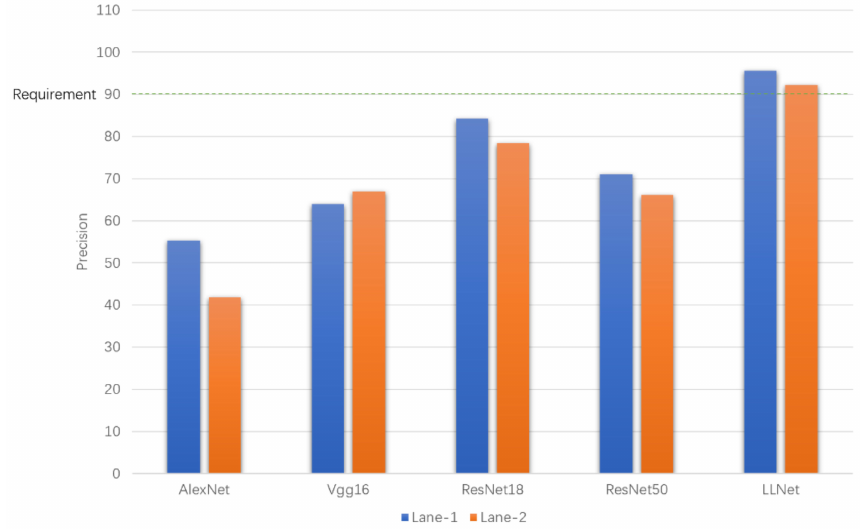
Figure 10. The requirement for precision and performance of the baselines and LLNet.